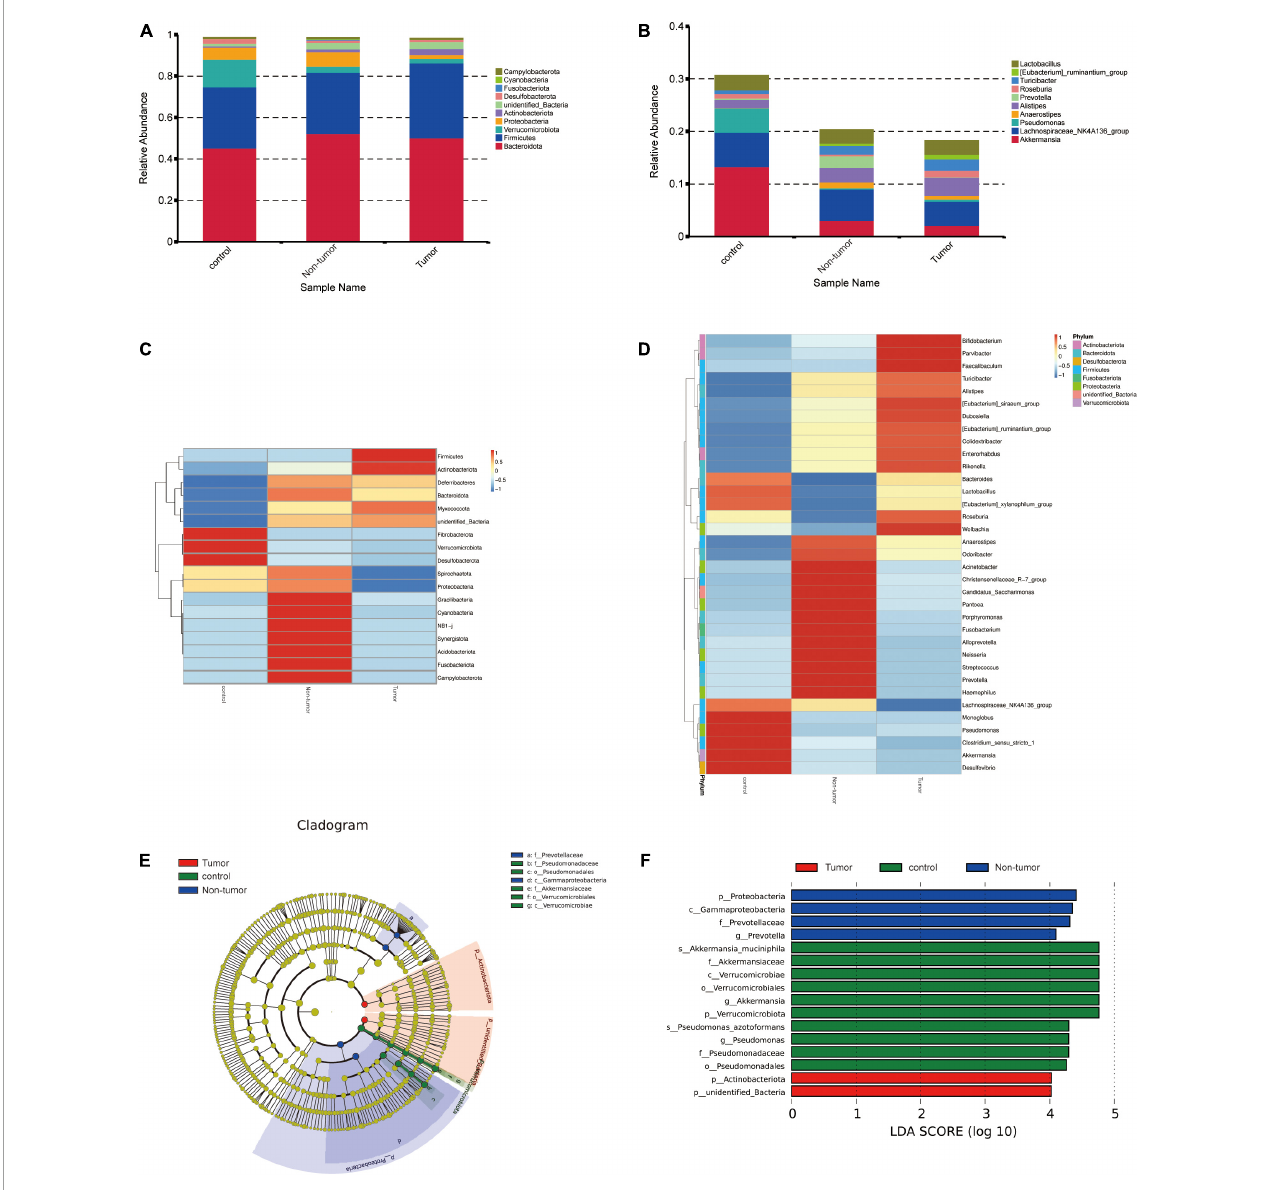
FIGURE3 Identification of the differential bacteria from the three groups. (A,B) Component proportion of bacteria at the phylum (A) and genus (B) level in different groups. (C,D) Heat maps to identify different fecal microbiota at the phylum (C) and genus (D) level in the different groups. (E) The cladogram to show specific differential bacteria in the three groups. (F) LEfSe indicating the different bacterial